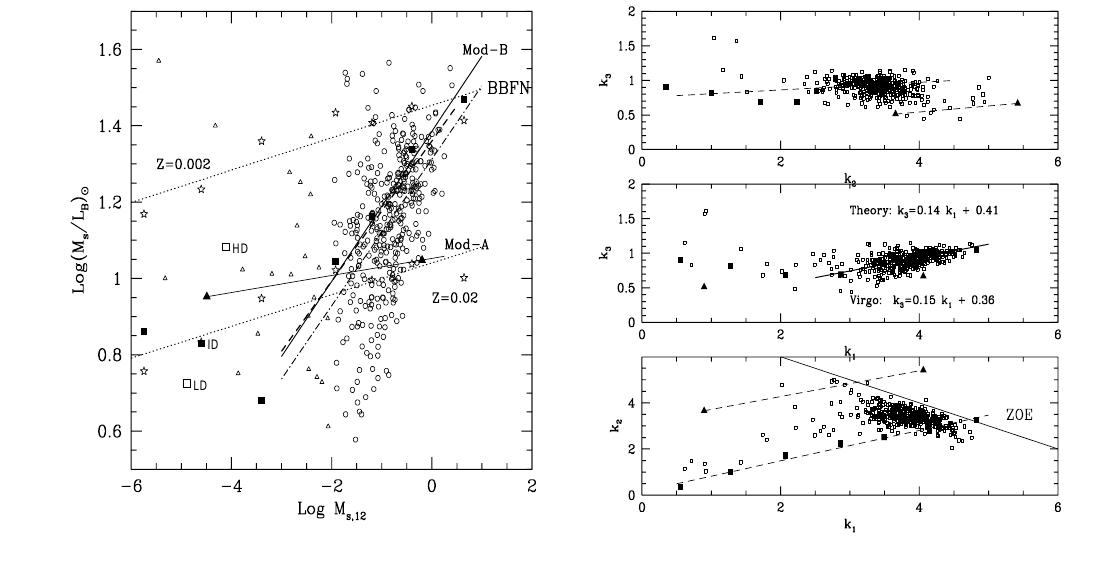
Figure 8. ( a ) Fundamental Plane of ETGs in the B passband, i.e. , the relation log( M /L ) s B ⊙ vs. log M , where M is the star mass in units of 10 12 M . The small open circles and s, 12 s, 12 ⊙ open triangles are the normal/giant and dwarf ETGs of ([89], BBFN), respectively. The thin dotted-dashed line labeled BBFN is the least square fit of the data limited to normal/giant vs. κ galaxies, i.e. , M > 10 10 M . The heavy dashed line shows the slope of the κ relation 3 1 ⊙ for ETGs in the Virgo cluster. This line can be shifted both horizontally and vertically vs. log M because its zero point has not yet been defined in the log( M plane. /L ) s B s, 12 ⊙ = 10 9 M with slightly different The filled squares are the models B of [23]. Those of M h ⊙ initial density are indicated by the labels LD (low density), ID (intermediate density) and HD (high density). The thick solid line labeled Mod-B is the least square fit of models B more massive than M = 10 10 M . The agreement with the best fit of the data in the same h ⊙ mass range (the dotted-dashed line) is remarkable. There is a small offset in the zero point which can be attributed either to log( M , a factor of 1.2 larger than the mean data, /L ) s, 12 B ⊙ or log M , a factor of two smaller than the mean data. Also in this case, the slope agrees s, 12 vs. κ with that of the κ relation. The filled triangles connected by the line labeled Mod-A 3 1 are the models of type A (very high initial over-density) by [23]. Finally, the large open stars are simple, largely analytical models with metallicities Z = 0.002 and Z = 0.02. The dotted lines labeled by the metallicity are their linear fits (see [23], for any other detail); ( b ) Three projections of the κ -space. In all panels the small empty squares are the ETGs of [89] from dwarfs to giants, whereas the filled triangles and squares are the models of type A and B of [23], respectively. The bottom panel shows the effect of I which over the whole e mass interval varies of a factor of about 300, whereas the mass-to-light ratio varies only by a factor of 3. The dashed lines are the best fits of the models as indicated. The solid line is the observational boundary κ > 8 beyond which the zone of exclusion (ZOE) is found + κ 1 2 (see [23], for a more detailed discussion of this plane). See the text for the discussion of this panel. The mid panel is the FP seen edge on. The solid line is the best fit of the theoretical models for galaxies with M . Reproduced with permission from [23]. Copyright 10 12 M h ≥ ⊙ 2002 John Wiley &